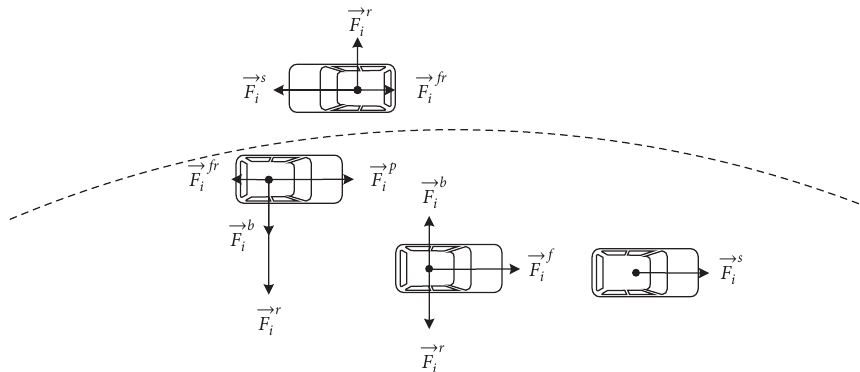
Figure 2: Social forces of the vehicles in the straddling work zone.